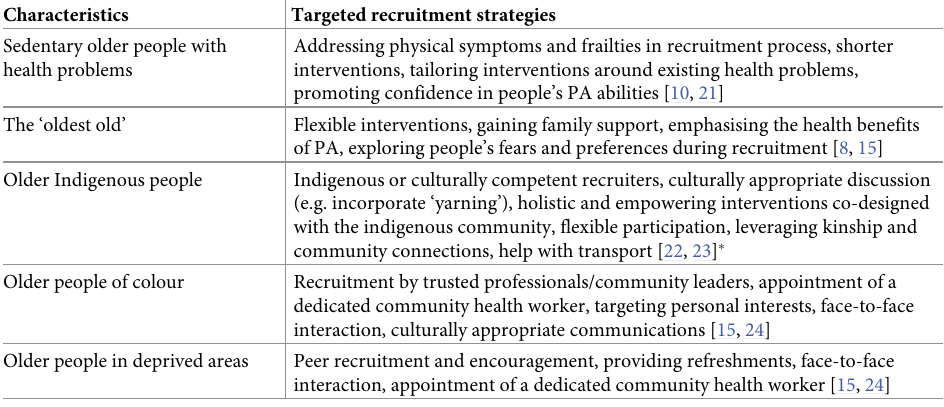
Table 1. Some potentially effective strategies for reaching hard-to-recruit groups in physical activity trials.